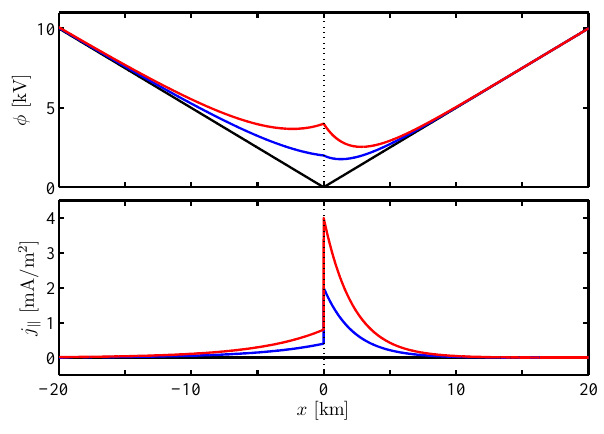
Fig. 4. Magnetospheric and ionospheric electric potential ˆ φ (black) and φ (blue or red) and field-aligned current j k (blue or red) for a converging electric field ( (cid:15) = 500mV/m) and changing magnetospheric populations across the interface, expressed as a change in the Knight constant ( K 1 = 0 . 2mA/kVm 2 , K 2 = 1mA/kVm 2 ). The two curves correspond to φ( 0 ) = 2kV (blue) and φ( 0 ) = 4kV (red). A constant conductivity 6 P = 5S is used.